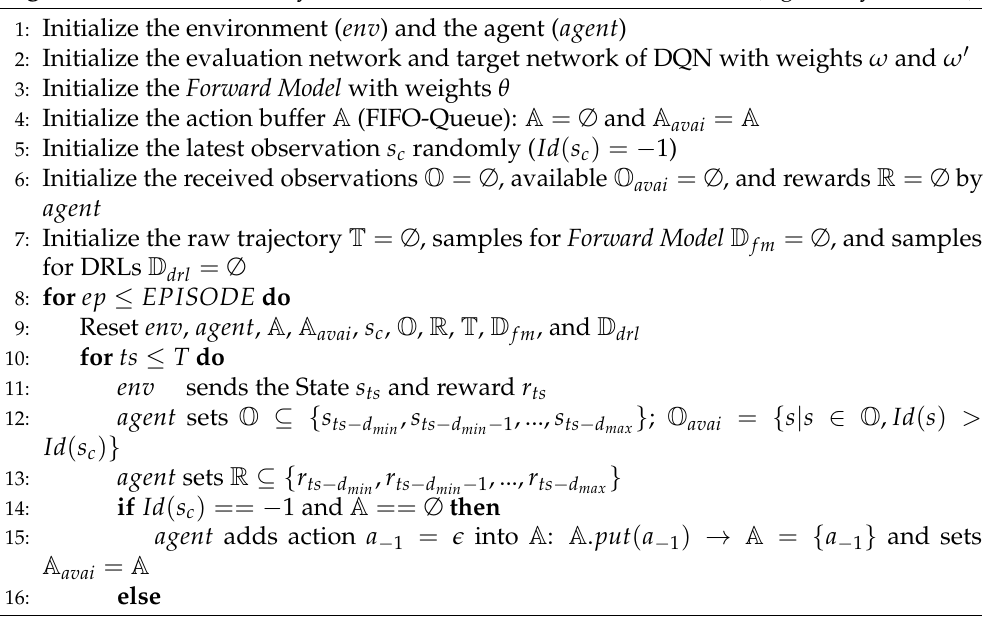
Algorithm 1 Random-Delay-Corrected DRL Framework with DCTS (e.g.,